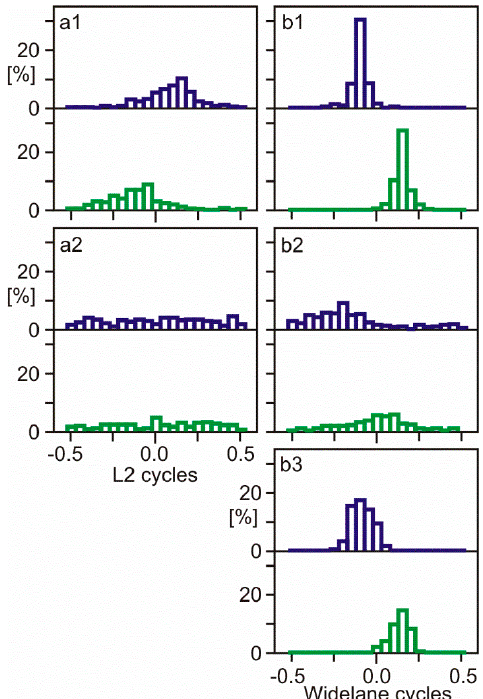
Figure 2. Distribution of fractional ambiguities of unaligned L2P(Y)/L2C carrier phase observations: ( a1 ) L2, short baseline, ( a2 ) L2, long baseline, ( b1 ) WL, short baseline, ( b2 ) WL, long baseline, ( b3 ) Melbourne-Wübbena linear combination, PPP; each panel consists of 2 sub-panels: upper sub-panels refer to L2C, lower sub-panels refer to L2P(Y); the bin width is 0.05 cycles.